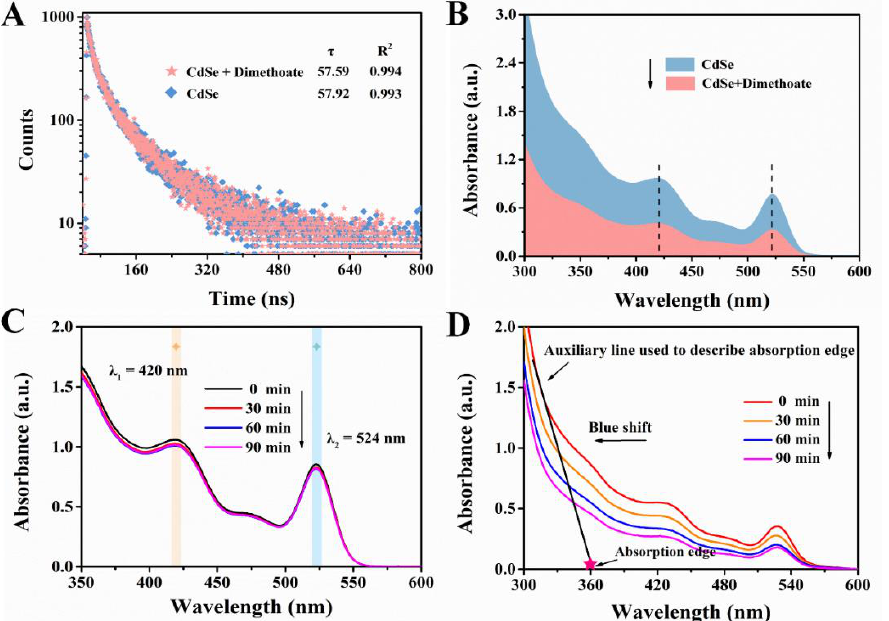
Figure 10. ( A ) Fluorescence decay profile of the CdSe QDs in the absence and presence of dimethoate. ( B ) UV-vis absorption spectra of CdSe QDs in the absence and presence of dimethoate. UV-vis absorption spectra of CdSe QDs without Cu 2+ ( C ) and with Cu 2+ . ( D ) Treatment with different time of irradiation by ultraviolet lamp.